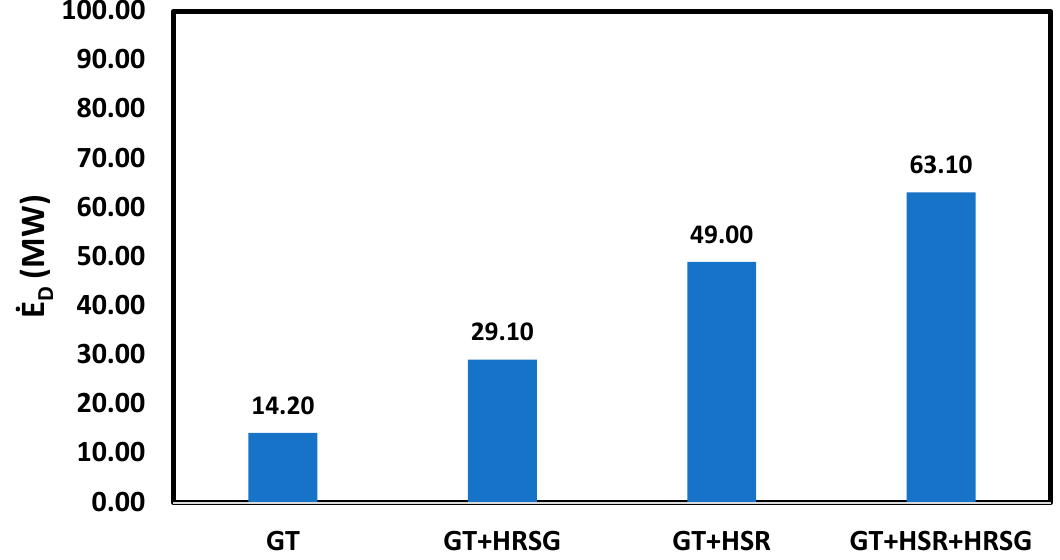
Figure 16. The annual average exergy destruction rate of four types of GT, GT + HRSG, GT + HSR, and GT + HRSG + HSR.